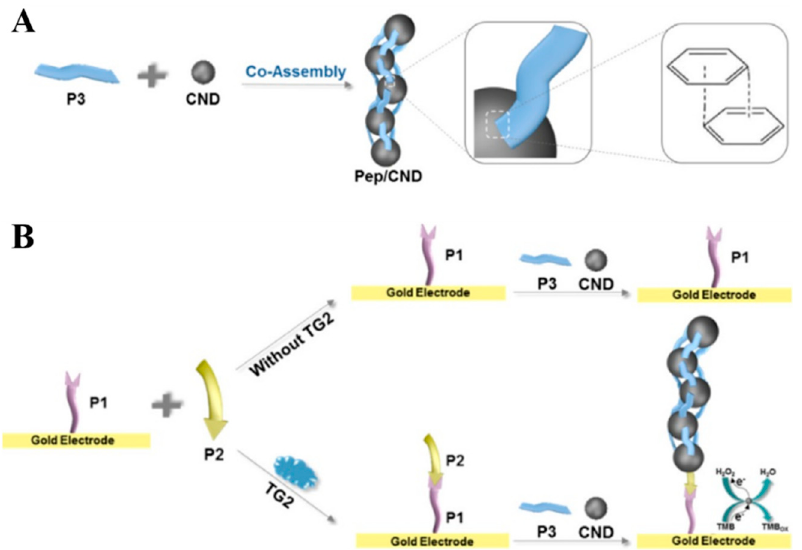
Figure 9. Schematic representation of ( A ) the co-assembly of P3 and CNDs and ( B ) the principle of the analysis of TG2 [81]. Copyright 2021 American Chemical Society.